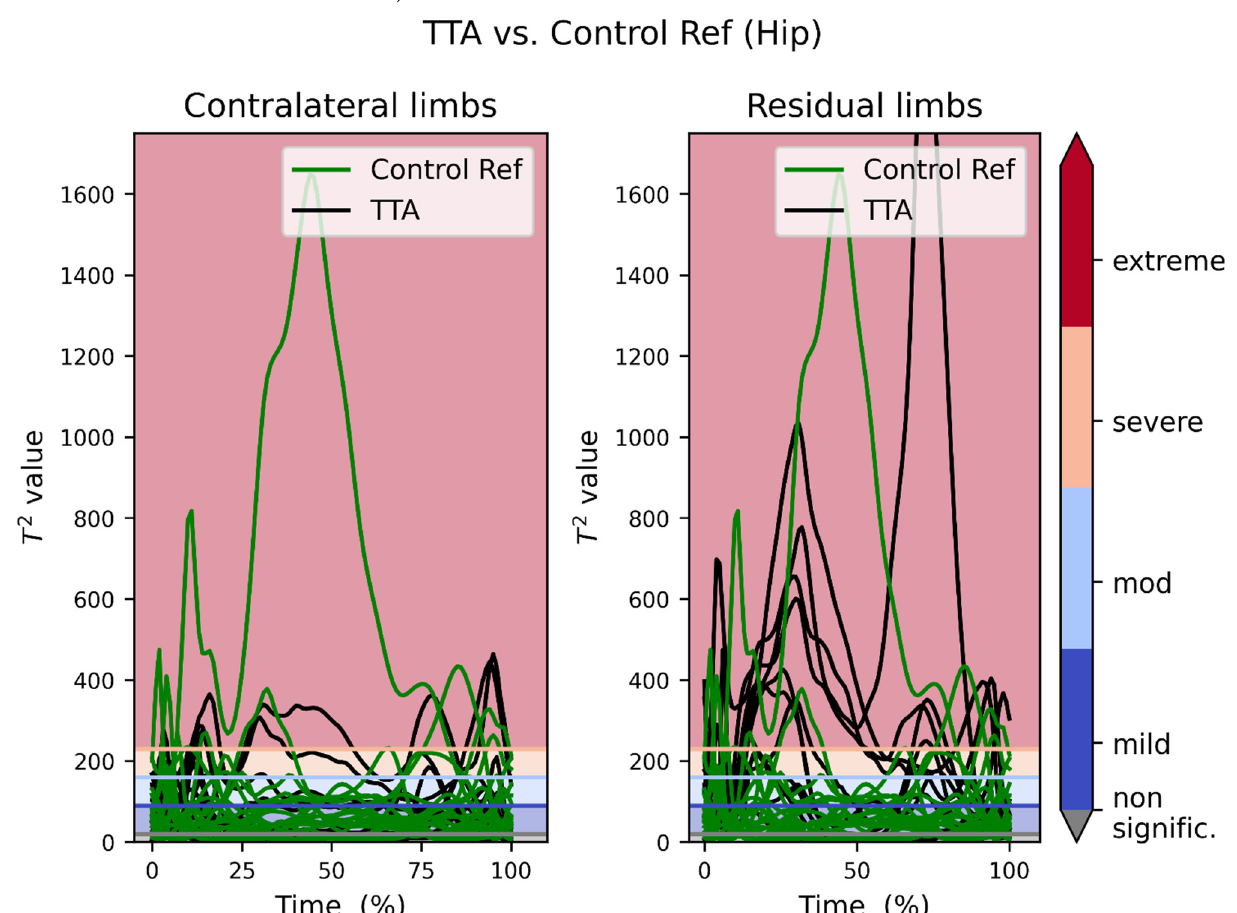
Figure 2. Transtibial amputation patients’ moments recording vs. reference recordings of the hip joint. The color scheme used for the horizontal lines is identical in all figures. The spiky top of one of the curves is truncated for space limitation.